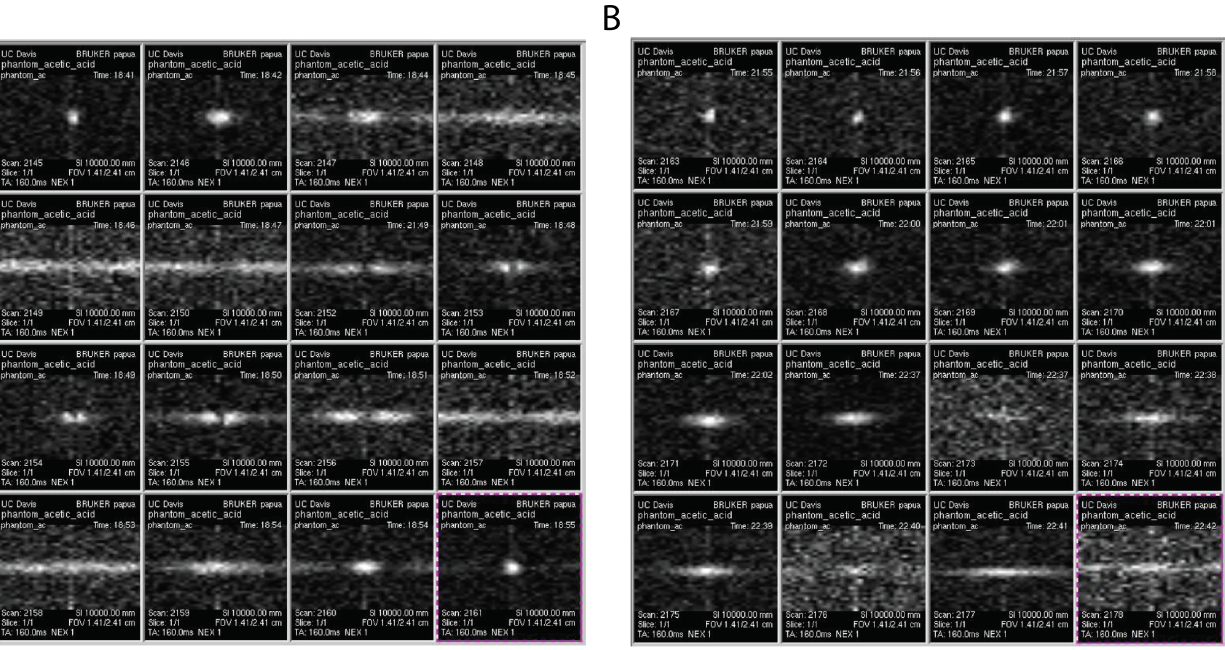
Figure 5. Diamond MRI with different flip angles. ( A ) The pulse durations are 5, 10, 15, ..., 80 µ s respectively for each image. We can determine that optimal pulse duration should be within 20 µ s. ( B ) The pulse durations are 4, 5, 6, ..., 19 µ s respectively for each image. The text on each image is the frame number, time when the images are taken, and FOV (1.41 × 2.41